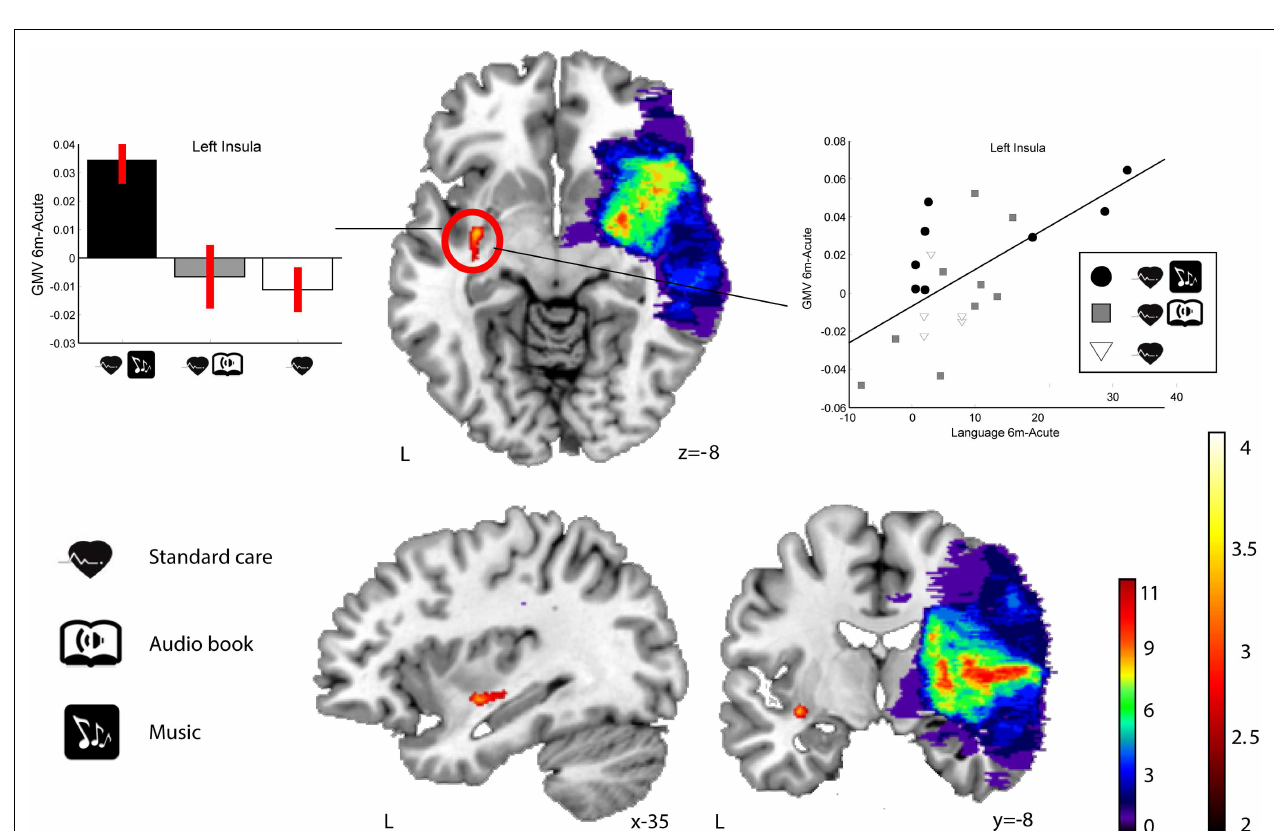
(white: CG, gray: ABG, black: MG).The scatter plot (right) shows the relationship between GMV increase in the insula cluster and improvement in language skills. Neurological convention is used. Results are shown at p < 0.01 (uncorrected) with ≥ 50 voxels of spatial extent and overlaid over a canonical template with MNI coordinates at the bottom right of each slice. L, left